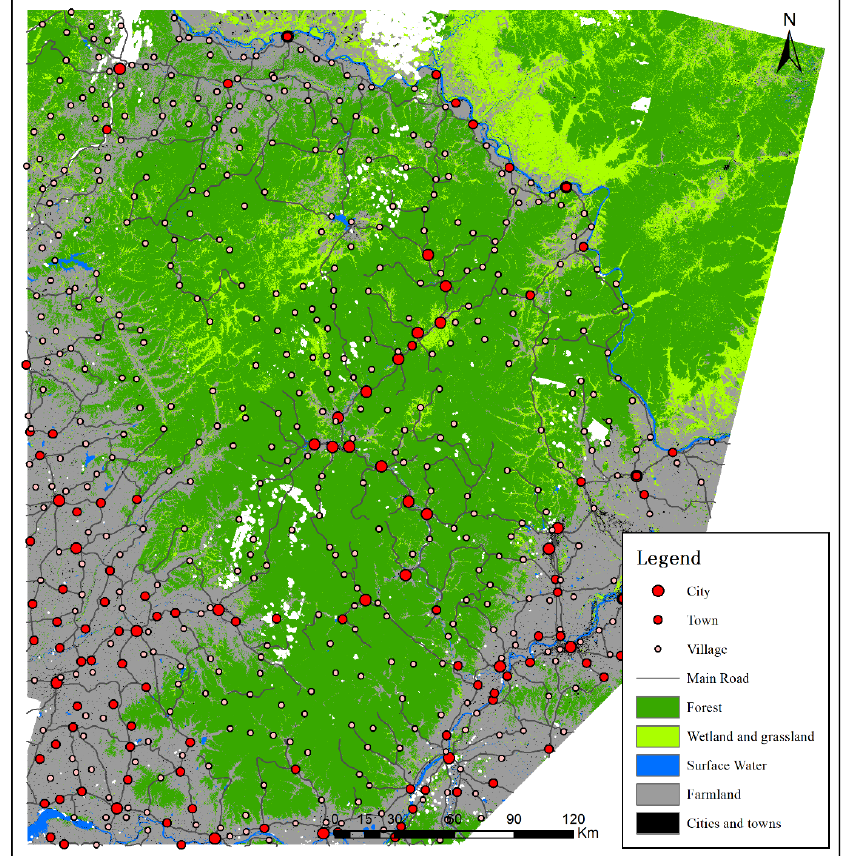
Figure A5. Map of human disturbance and anthropogenic activity of Lesser Khingan.